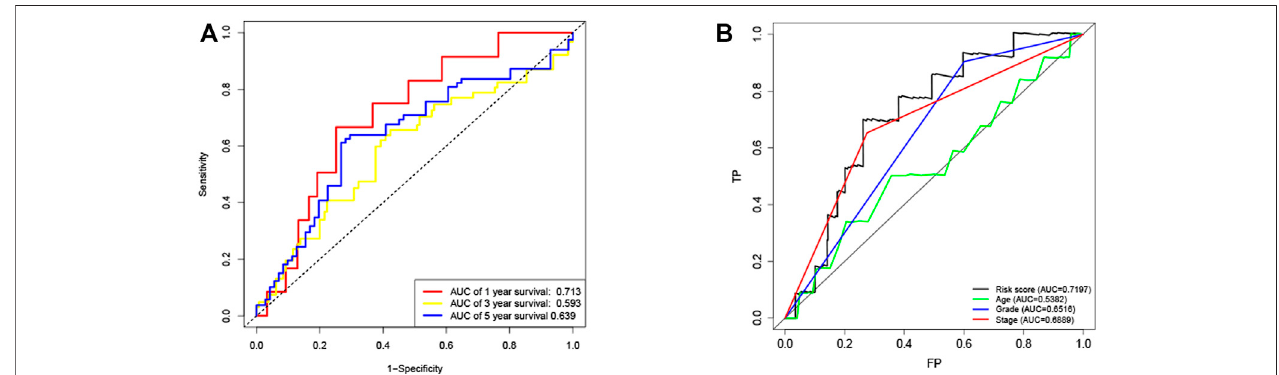
FIGURE4| ROCcurvesoftheriskscore (A) ROCcurvesdemonstratedthepredictiveef fi ciencyoftheriskscoreat1,3and5 yearsintraincohort. (B) ROCcurves demonstrated the predictive ef fi ciency of the risk score, age, grade and stage at 1 year in training cohort.